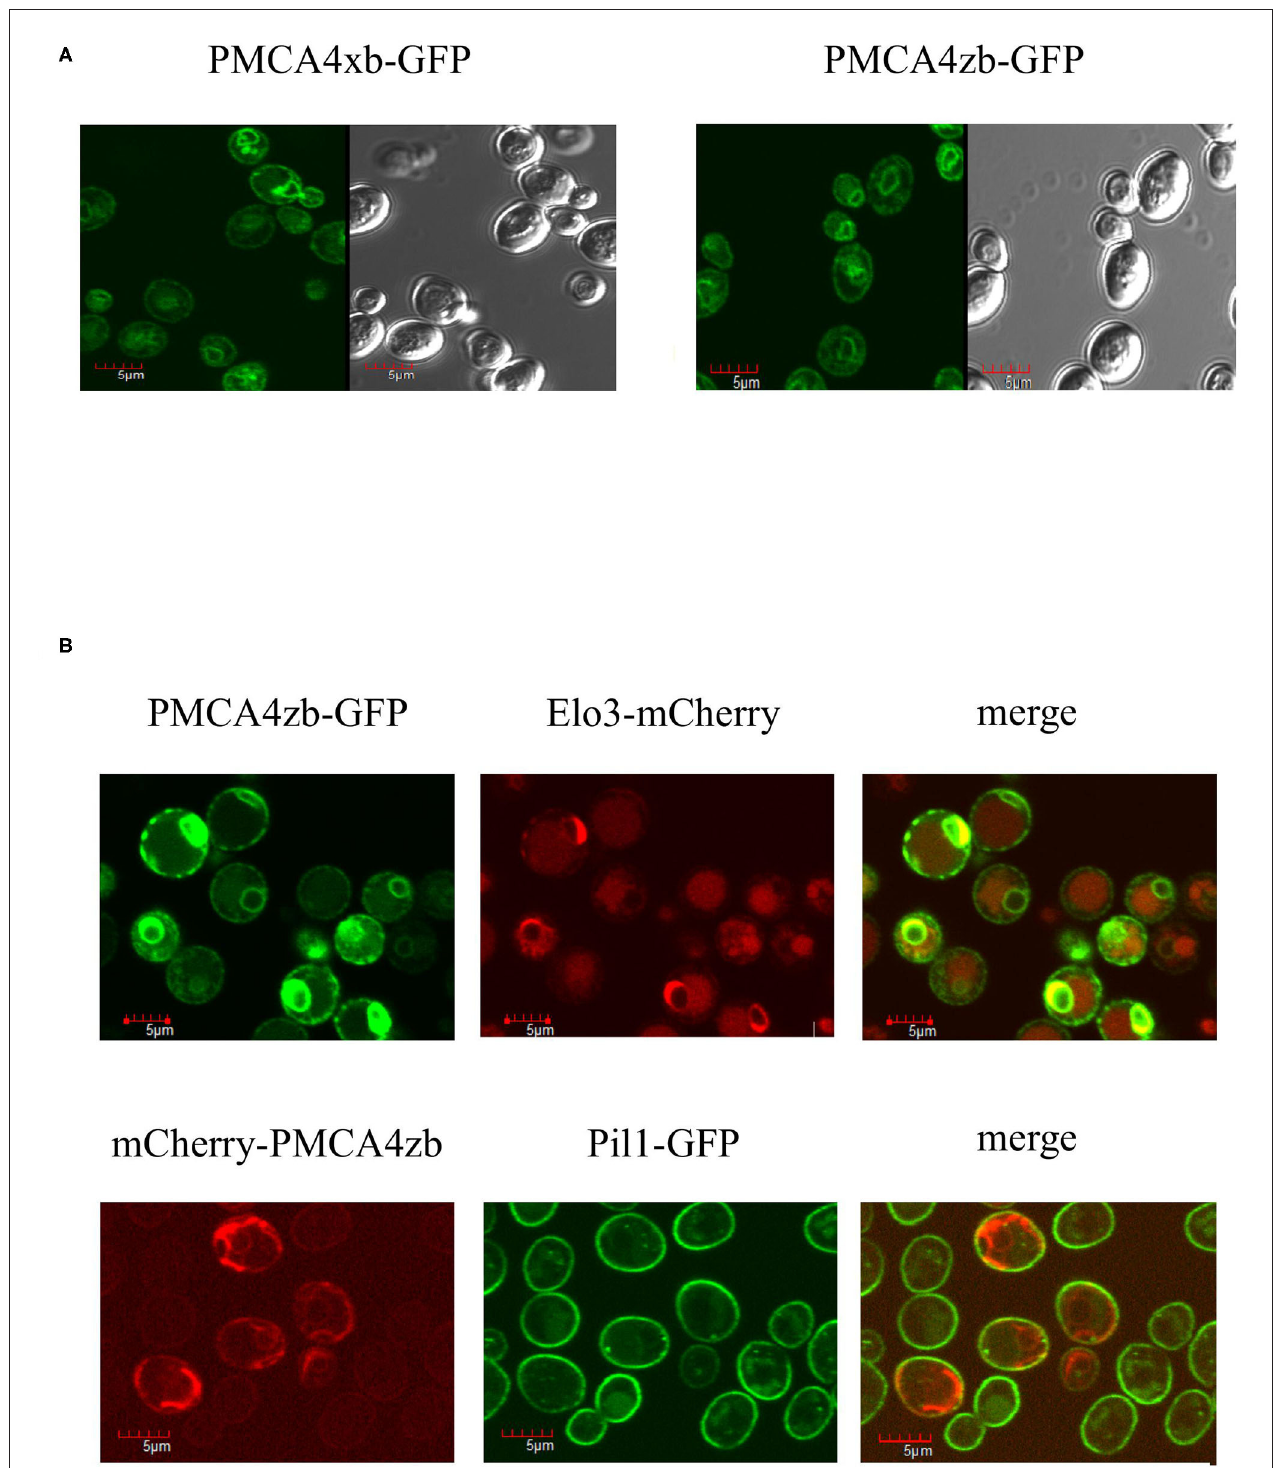
FIGURE 3 | (A) Expression of PMCA4xb and PMCA4zb-GFP in yeast cells. Saccharomyces cerevisiae cells (strain DBY2062) were transformed with the pMP625 vector containing the DNA coding for PMCA4xb-GFP and PMCA4zb-GFP and selected in a Leu − media. The confocal fluorescent image (EGFP filter, LUT 2300,amplificationx60)isshownontheleft.Theprominentyeastvacuolescanbedistinguishedinthevisibleimageshownontheright. (B) Intracellularlocalizationofthe